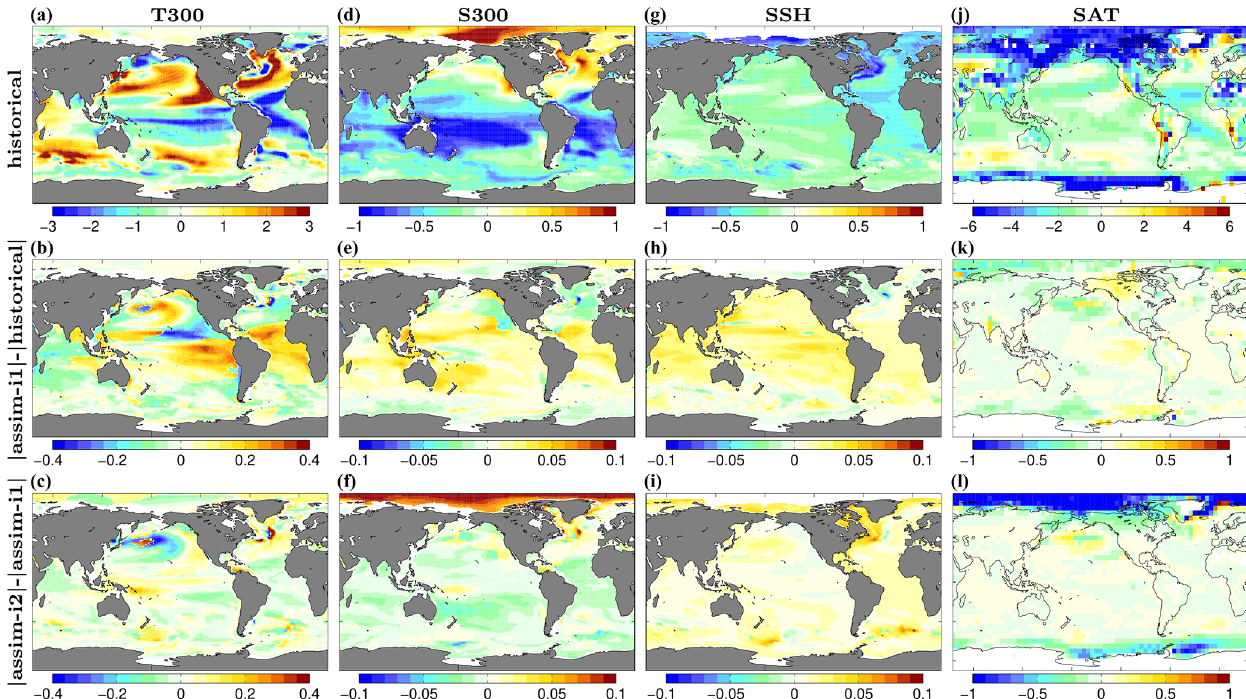
Figure 3. Annual-mean climatological biases for T 300 (a–c) , S 300 (d–f) , SSH (g–i) and SAT (j–l) . Biases of historical (top row), differences between absolute biases in assim-i1 and historical (middle row), differences between absolute biases in assim-i2 and assim-i1 (bottom row). Cold colours imply bias improvement. The EN4.2.1 objective analysis (Good et al., 2013) is used to estimate the biases of T 300 and S 300 over 1950–2018. The global 3-D thermohaline field reprocessed dataset (ARMOR-3D L4; Larnicol et al., 2006) is used to estimate the biases of SSH over 1993–2018. The Hadley Centre – Climate Research Unit Temperature dataset version 4 (HadCRUT4) (Morice et al., 2012) is used to estimate the biases of SAT over 1950–2018.